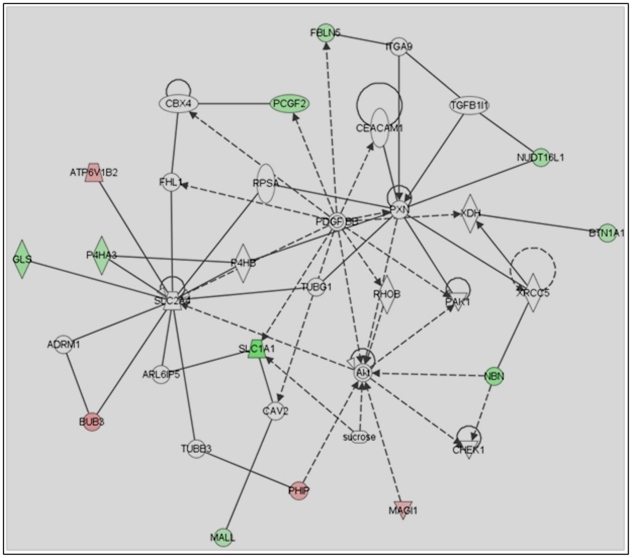
Ingenuity Pathway Analysis (IPA) of cell survival related genes in p85α−/− MCp's in response to SCF stimulation.Altered genes in p85α−/− cells after SCF stimulation were analyzed by IPA software to analyze their closely associated gene network. Significantly altered cell survival related genes in p85α−/− MCp's in response to SCF stimulation were indicated.